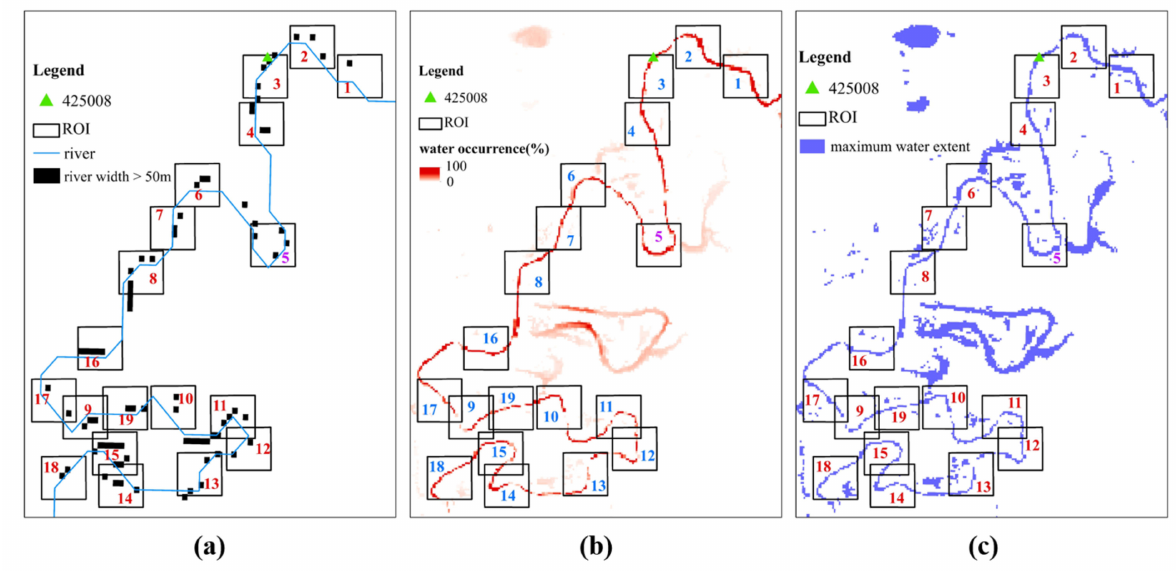
Figure 8. Selected ROIs near the Gauge 425008 as candidate virtual gauges, shown with ( a ) river width, ( b ) water occurrence, and ( c ) maximum water extent. The number labelled in the ROI stands for its